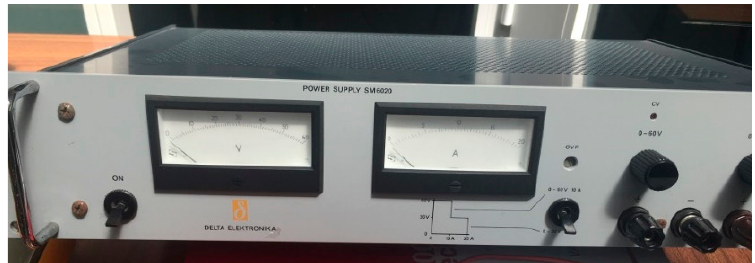
Figure 4. DELTA ELECTRONIKA Power Supply SM6020 used for the dry cell